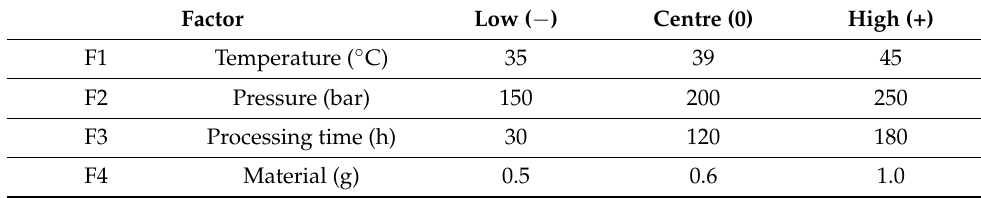
Table 1. Factors for the experimental factorial design study.